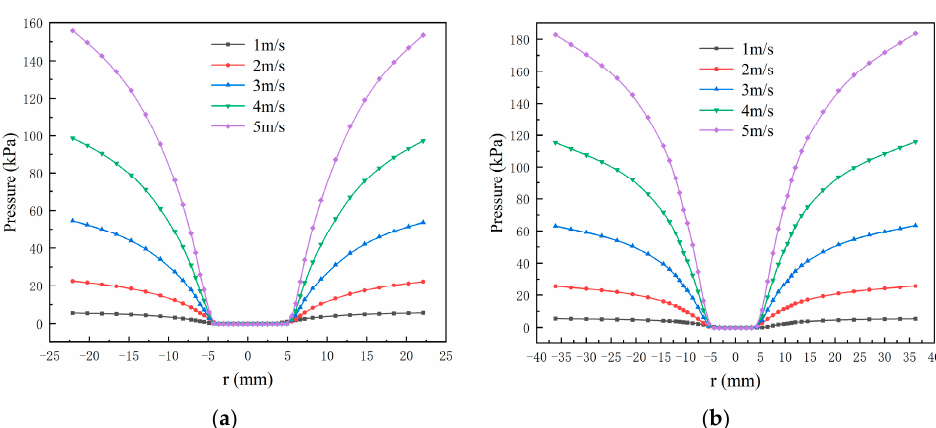
Figure 4. Clouds of static pressure under different feed rates.